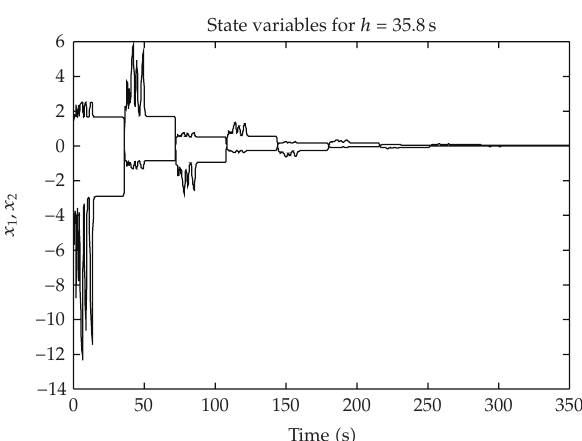
Figure 10: State trajectories evolution for a delay of 35.8